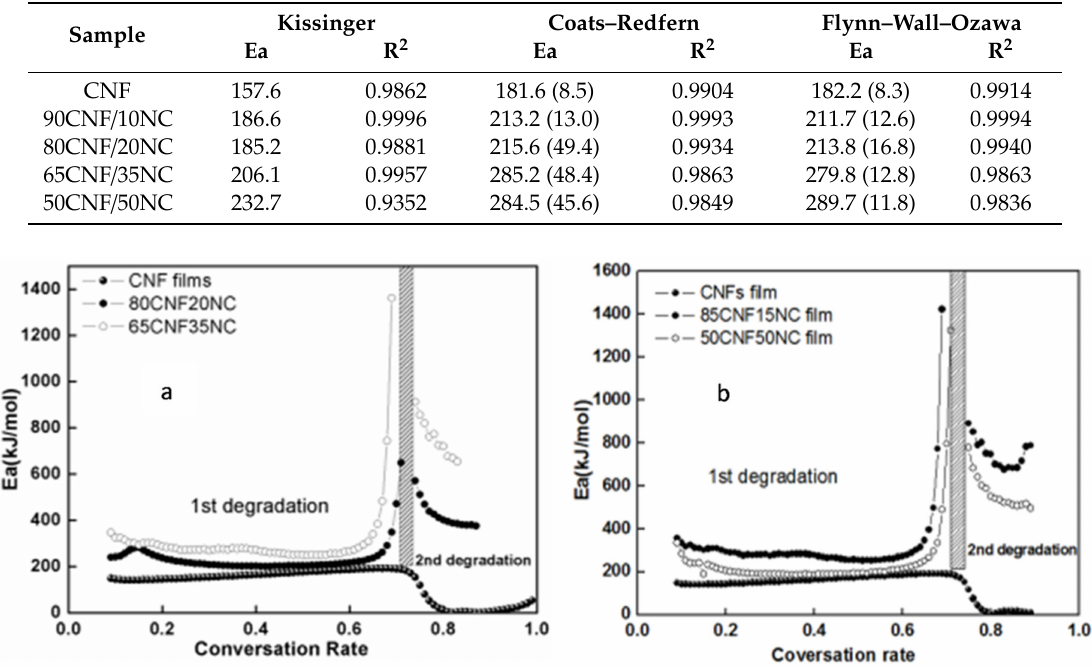
Table 4. Apparent Ea of CNF / NC composites calculated by three model-free methods.